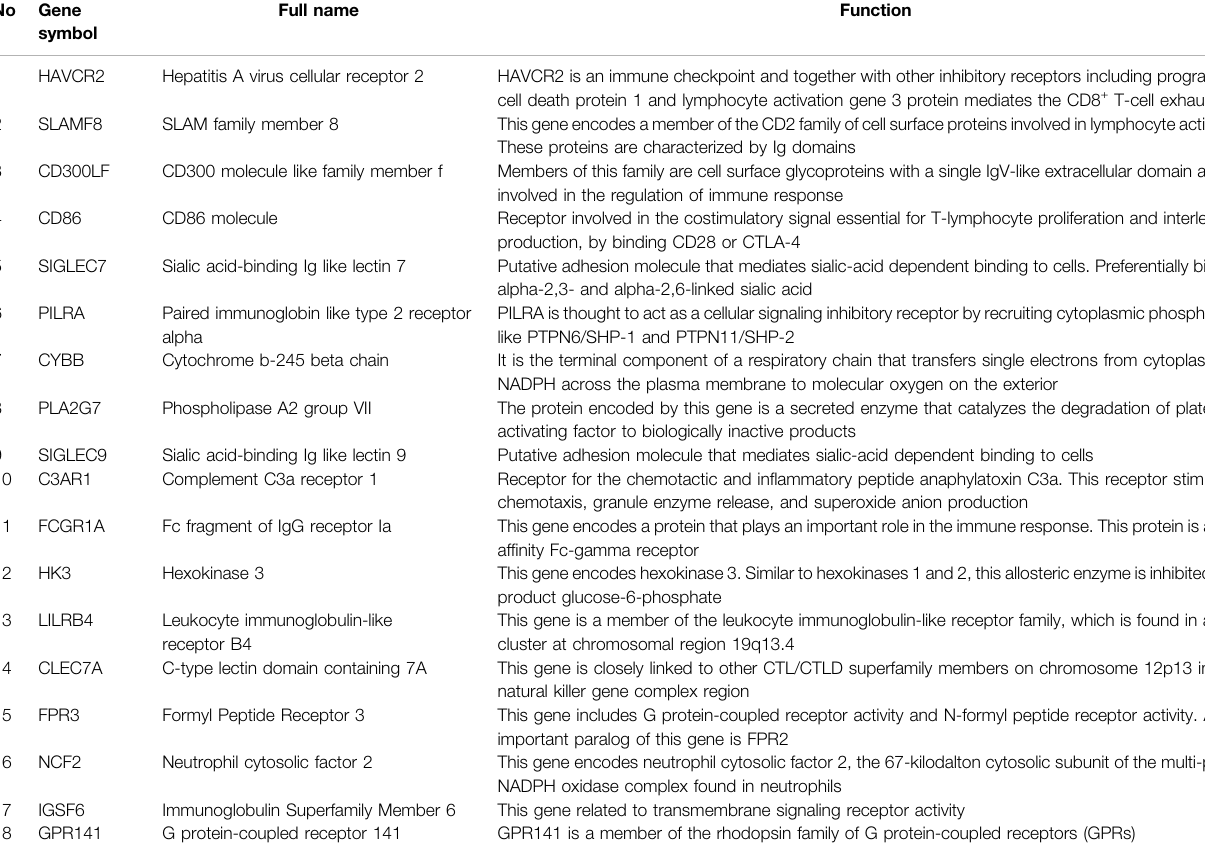
TABLE 1 | Functional roles of 18 hub